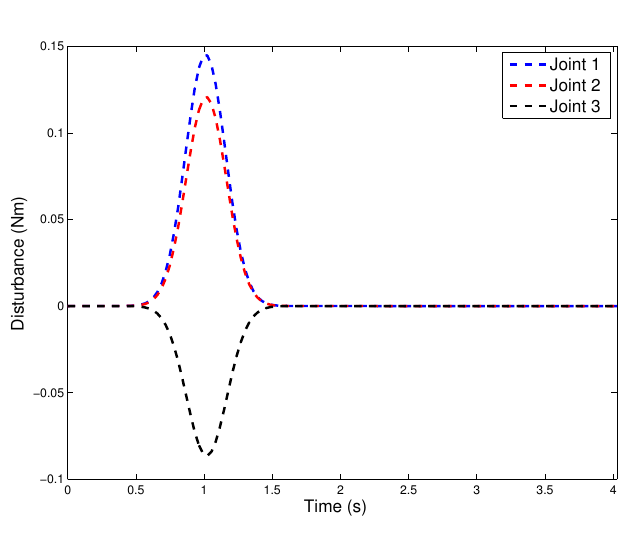
Figure 9. Torque